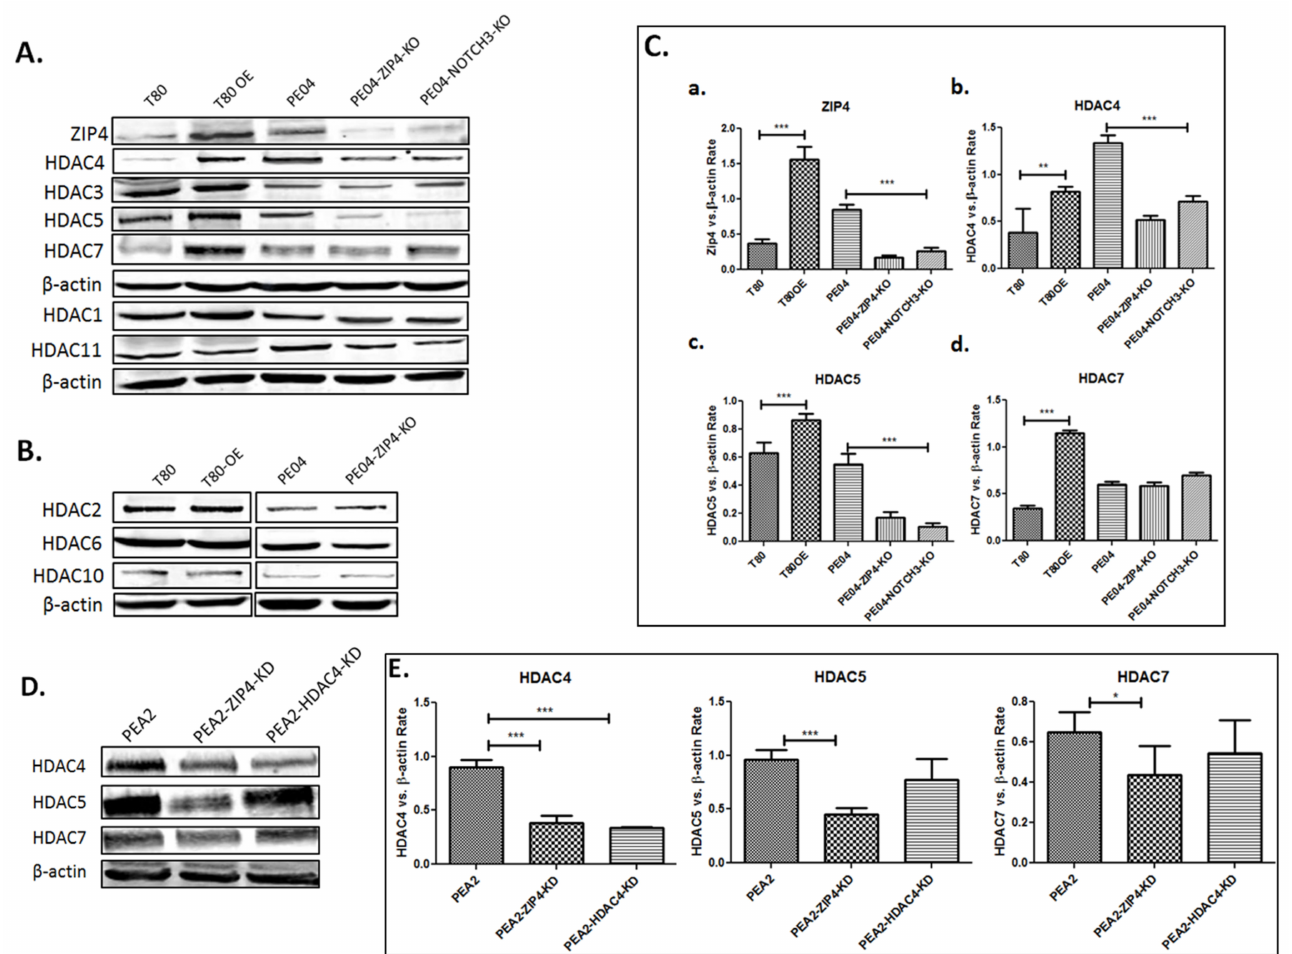
Figure 2. ZIP4 upregulated Class IIa HDACs. ( A , B ). ZIP4-OE up regulated the expression of HDAC4, 5, and 7; ZIP4-KO and NOTCH3-KO downregulated the expression HDAC4, 5, and 7 in PE04 cells, with little or no effect on other classes of HDACs. ( C ). Summary of quantified Western blot results from > three independent experiments for ZIP4, HDAC4, 5, and 7. ( D ). PEA2 cells expressed relatively higher levels of HDAC4, 5, and 7 than PEA1 cells; ZIP4-KD reduced expression levels of HDAC4, 5, and 7 in PEA2 cells. ( E ). Summary of quantified Western analyses results from > three independent experiments. * p < 0.05; ** p < 0, 01; *** p <